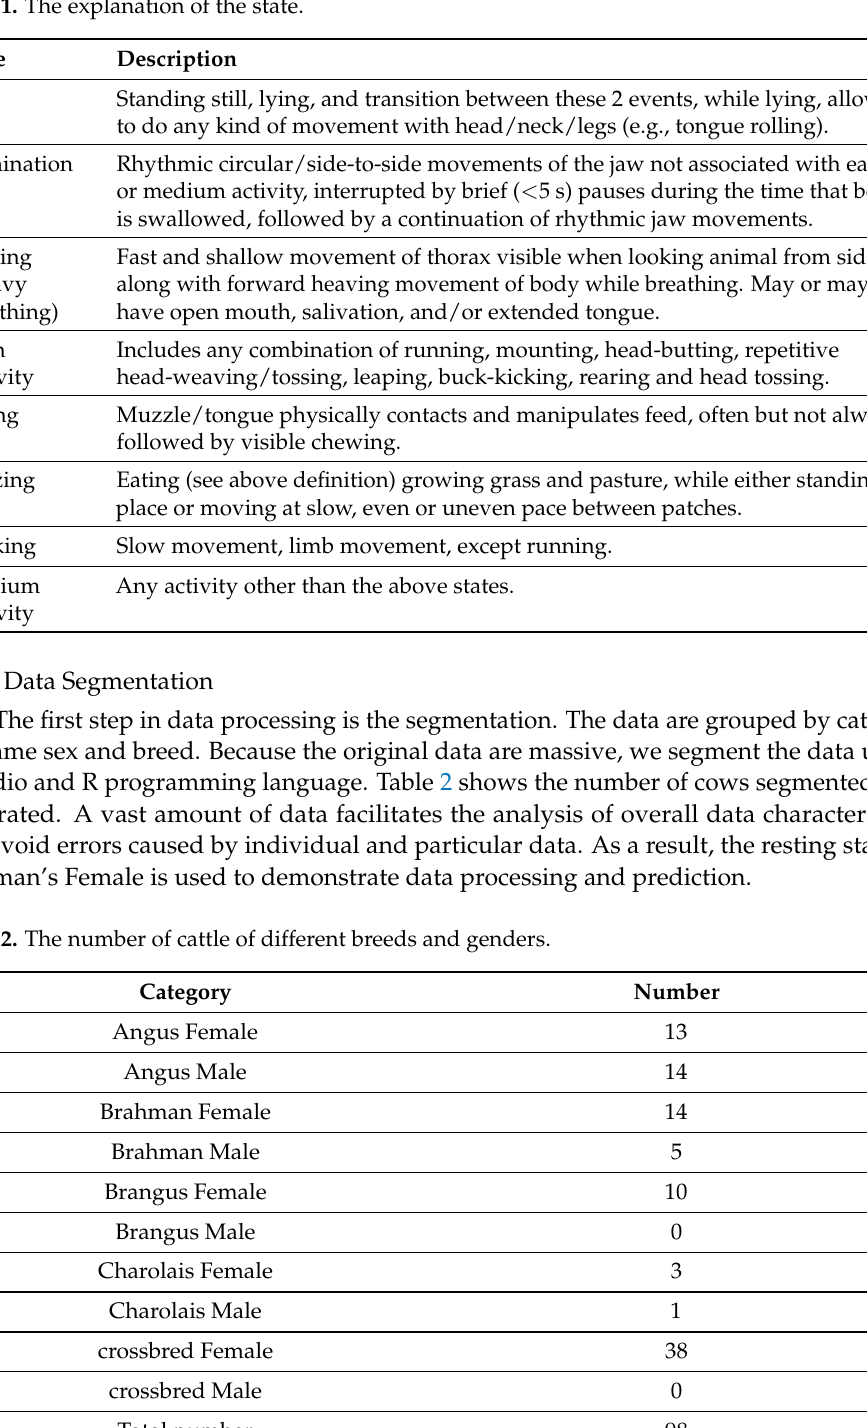
Table 1. The explanation of the state.